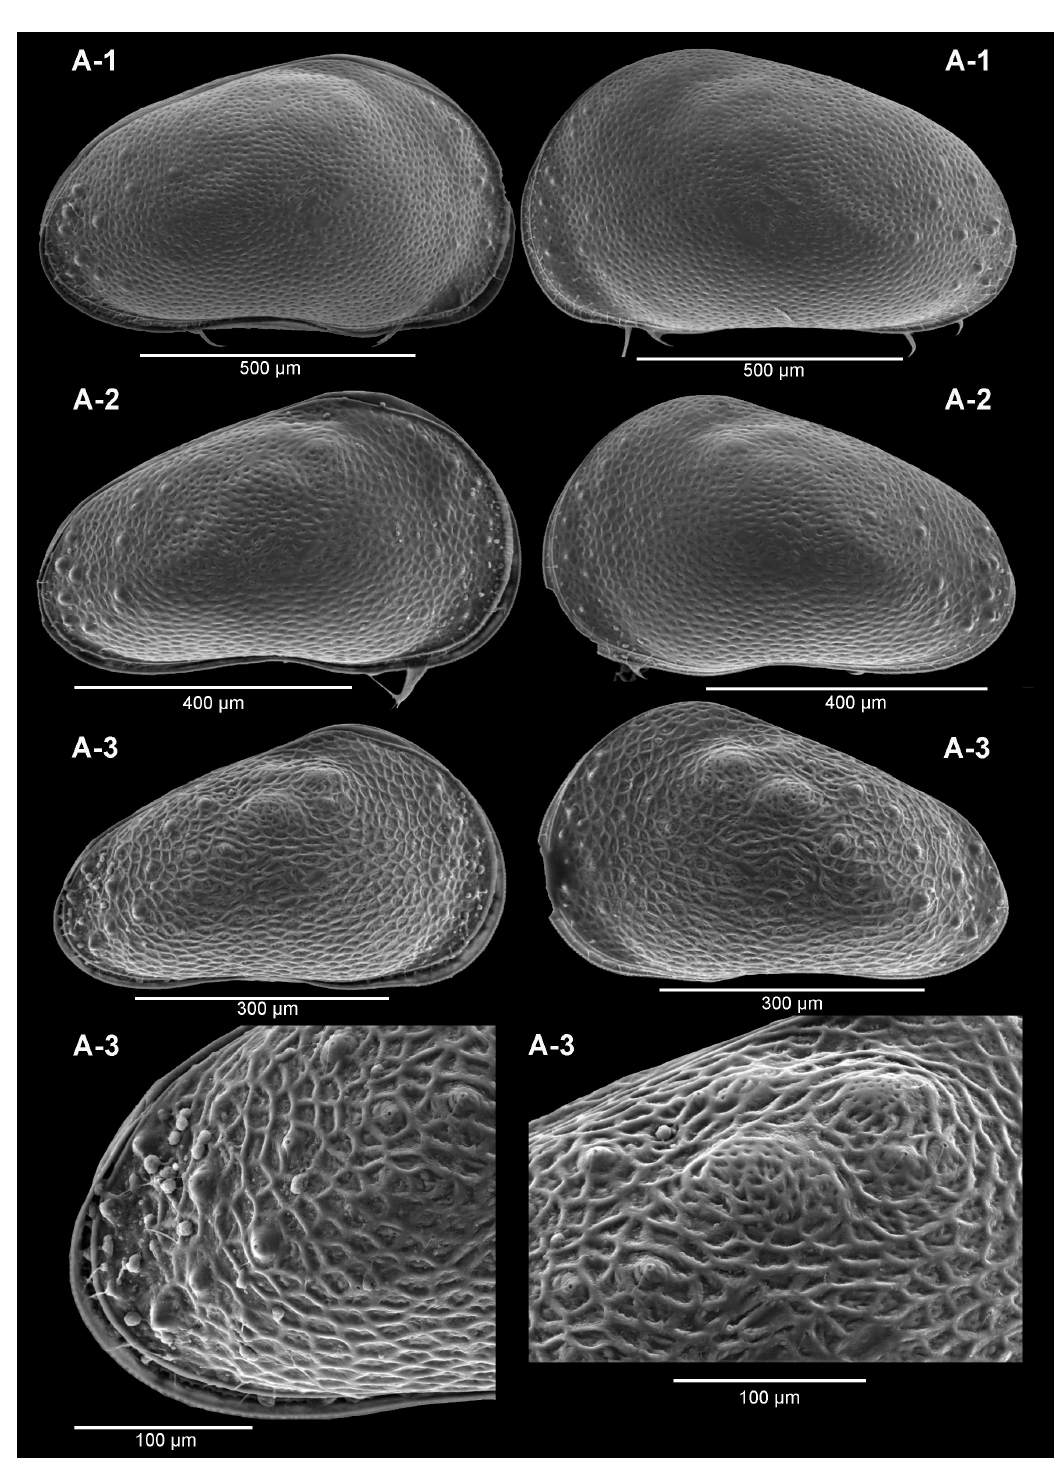
Fig. 20. Lateral views of carapaces of Bennelongia dedeckkeri Shearn et al ., 2012 from Lake Dunn for the last 3 instars (A-3 to A-1) to show the changes in external ornamentation and the progressive disappearance of the domes and cones with ontogeny. Right lateral views are displayed in the top 3 left images, and left lateral views on the right. Details of the cones (bottom left) and the domes with fewer cones (bottom right) of A-3 specimens are portrayed. Note the presence of nodules stuck to the anterior portion of the valve of bottom left